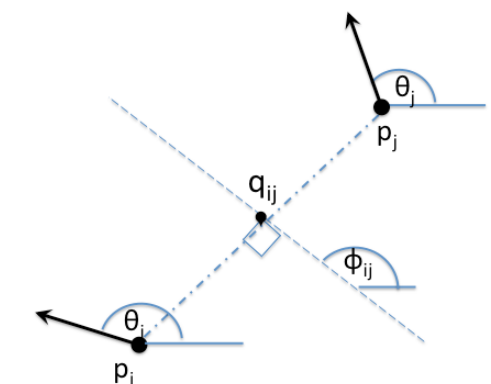
Figure 2. Geometry of points contributing to symmetry